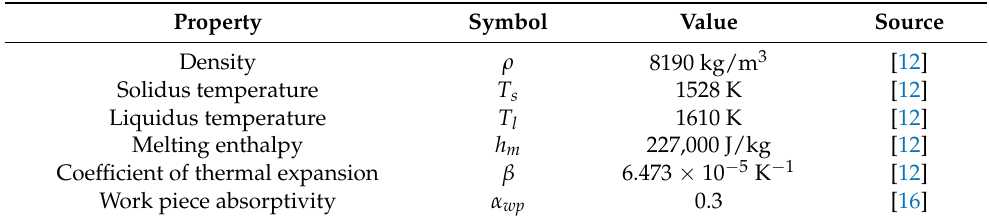
Table 1. Constant material properties of Inconel 718 for the numerical simulations according to Pottlacher et al. [12] and Anderson et al. [16]. Pottlacher et al. [12] and Anderson et al. [16].